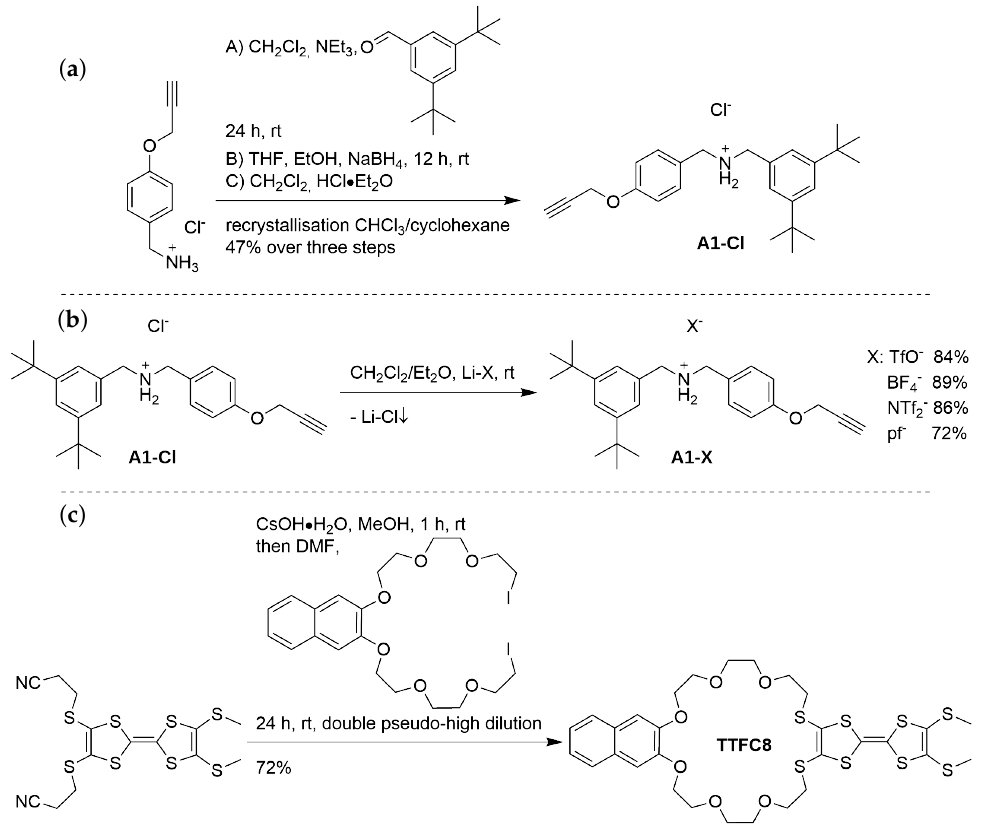
Figure 5. ( a ) Synthesis of A1 -Cl by a modified procedure [63]. A: The imine formation between 3,5-di-tertbutyl-benzaldehyde and (4-(prop-2-yn-1-yloxy)phenyl)methanaminium chloride [64] is favoured by the binding of water to anhydrous sodium sulfate. B: Reduction of the formed imine by sodium tetrahydrido borate. C: A1 -Cl is obtained by neutralisation of the amine with HCl raw salt is purified by repeated recrystallisation from CHCl 3 /cyclohexane 1:4. ( b ) The counter anion exchange is realised through a double displacement reaction of A1 -Cl with the respective lithium salt of the anion. Precipitation of lithium chloride shifts the equilibrium towards the highly soluble A1 -X salts. ( c ) The reported synthesis of the macrocycle TTFC8 [63] was adapted by adding both macrocycle precursors, at a very slow rate, to the reaction mixture.